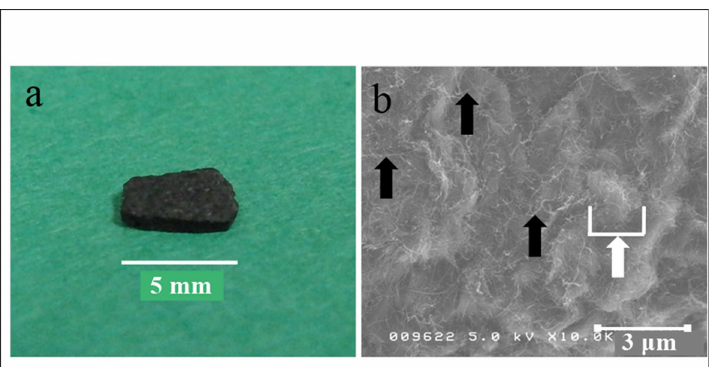
Fig 1. MWCNT block. (a) A macroscopicimage of an MWCNT block. (b) Scanning electron photomicrograph of an MWCNT block. Black arrow: nanosizeirregularity formed by MWCNT fibers. White arrow: microsize irregularity formed by an aggregateof MWCNT fibers.